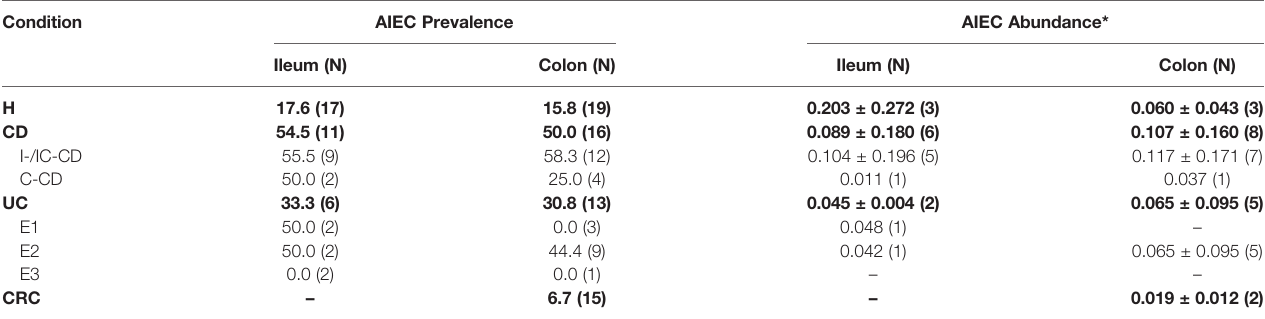
TABLE 3 | AIEC prevalence (frequency of patients with AIEC and/or AIEC-like strains) and abundance (estimated AIEC and/or AIEC-like isolates/total Enterobacteriaceae) according to biopsy location.